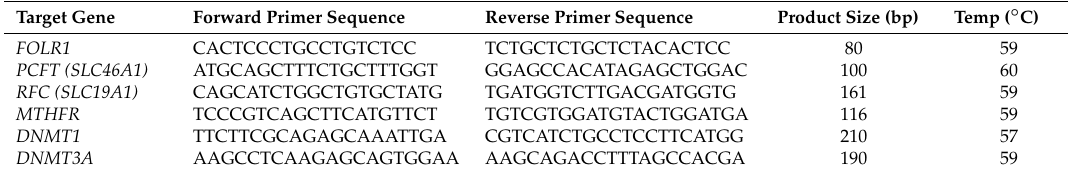
Table 2. Summary of primers used together with qPCR product and